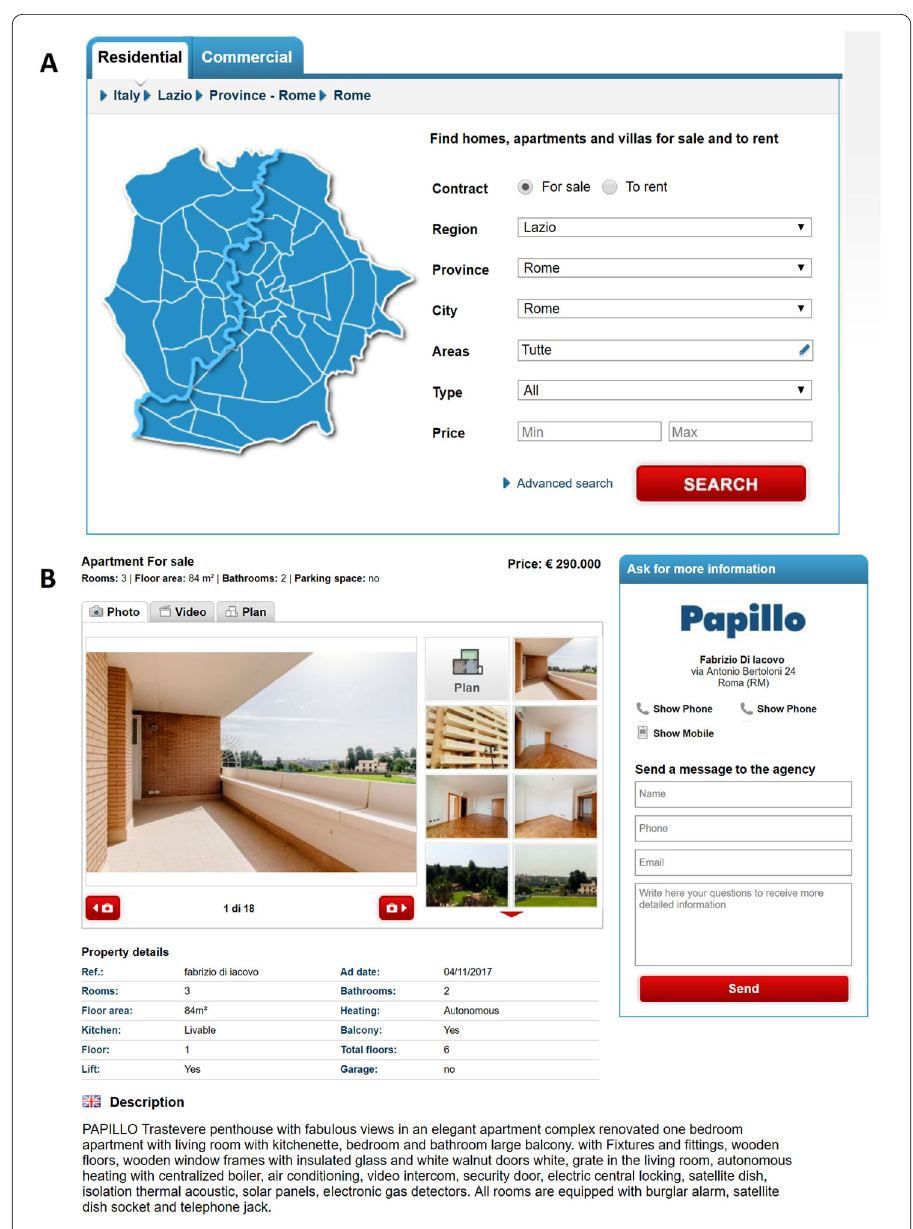
Figure 1 Screenshots from the webpage of Immobiliare.it (English version). ( A ) Search engine. ( B ) Sample ad. The form to contact the agency is on the right